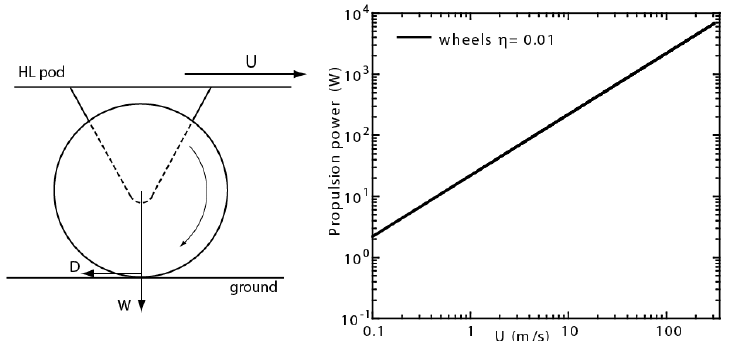
Figure 1. Propulsive power requirement of a simple wheeled system (shown left) with η = 0.01. Linear scaling ( ∼ U ) of propulsive power.